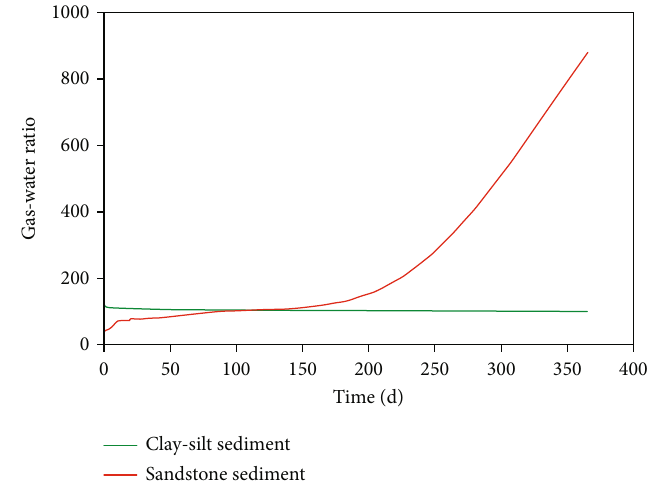
Figure 21: The comparison of the gas-water